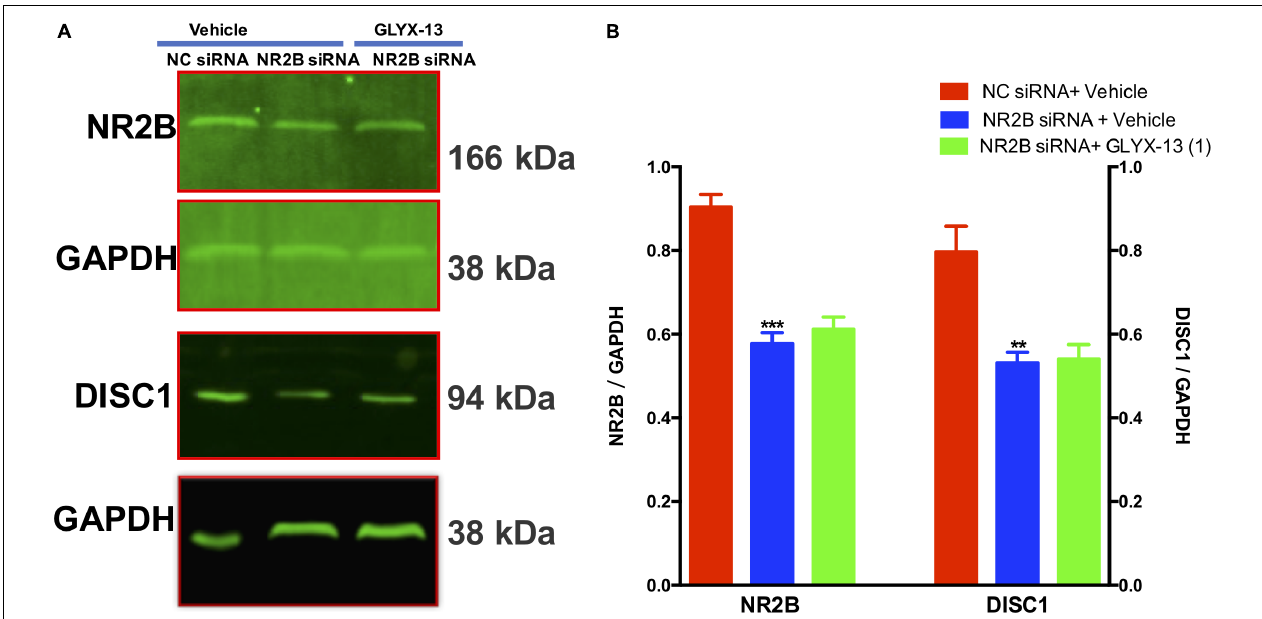
FIGURE 9 | GLYX-13 did not reverse the downregulation of DISC1 induced by NR2B siRNA in mice. (A,B) Representative images of immunoblots using antibodies against NR2B and DISC1 along with quantitative analyses. Data are expressed as the mean ± SEM ( n = 4 per group for western blotting; ∗∗ P < 0.01 and ∗∗∗ P < 0.001 compared with the NC siRNA + vehicle-treated